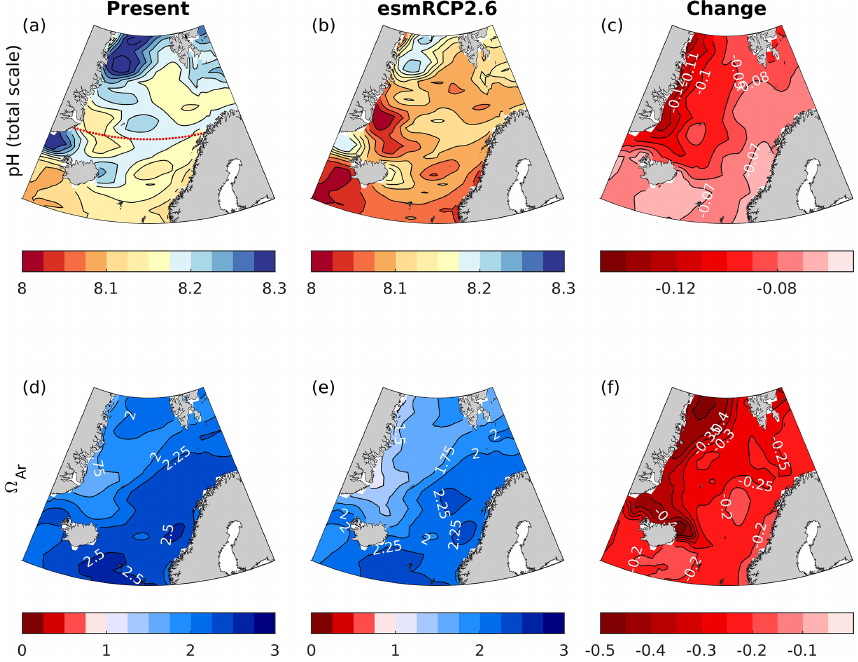
Figure 9. Maps of surface water (0m) pH and (cid:127) Ar for the present day (1996–2005) and the esmRCP2.6 future (2090–2099), as well as the changes between the periods. The data input of the maps is based on GLODAPv2 gridded climatologies combined with the change from the NorESM1-ME. The dotted red line in panel (a) shows the location of the cross section presented in Fig. 10.